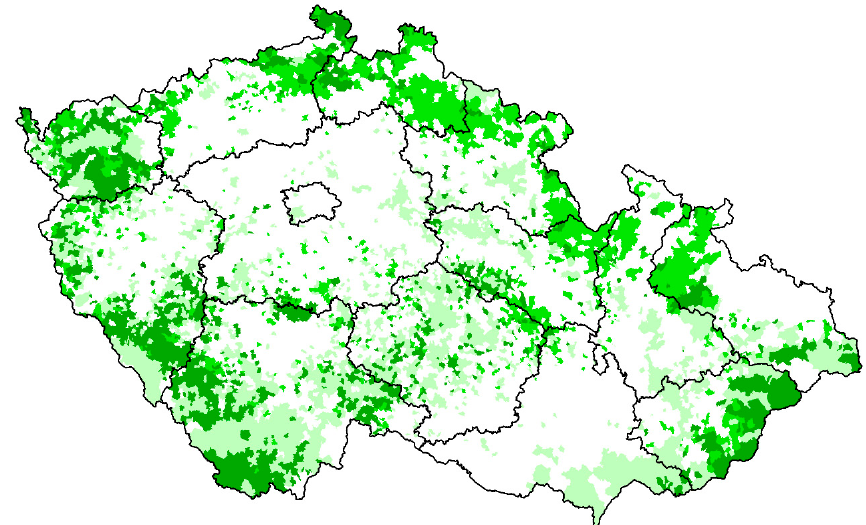
Figure 5. Changing distribution of permanent grasslands: BTUs that lay in the concentrated half (C) both in 1845 and 2010 (dark green), BTUs that entered C between 1845 and 2010 (medium green) and BTUs that left C between 1845 and 2010 (light green). Source: own calculation, LUCC Czechia database.